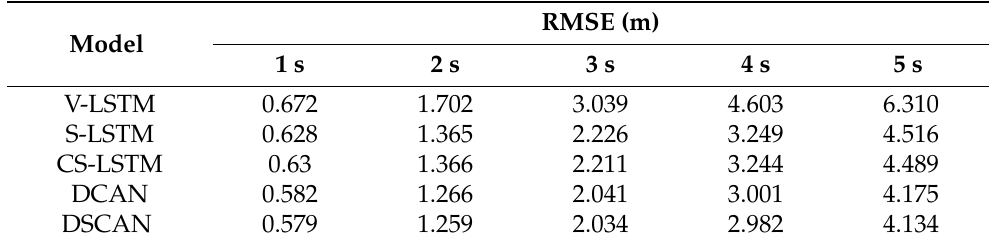
Table 1. Results: root mean squared prediction error (RMSE) values over a 5 s prediction horizon for the models